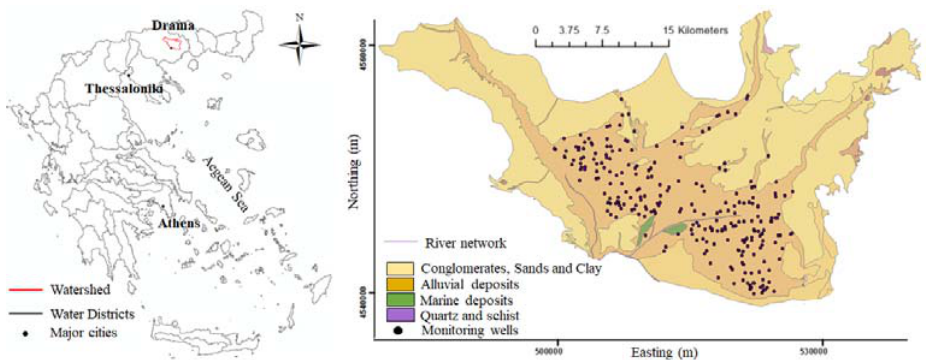
Figure 1. Map of the study area and its location in the Greek